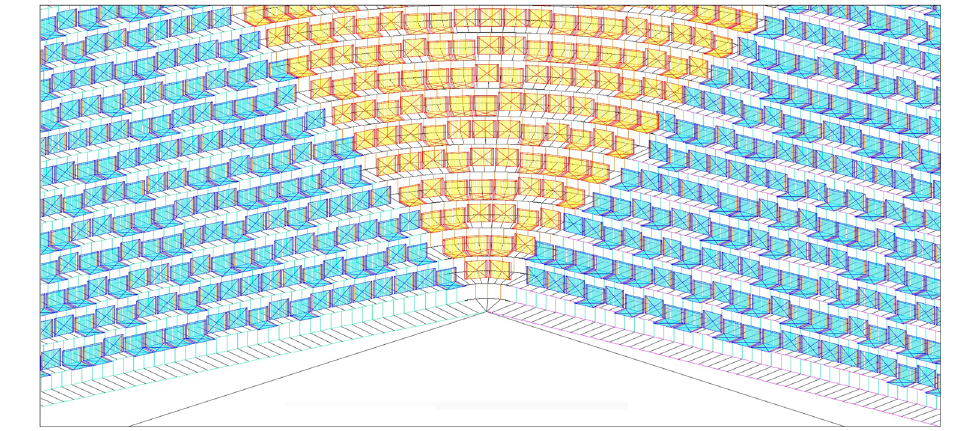
Figure 2: The stands in the corner ( a close - up )